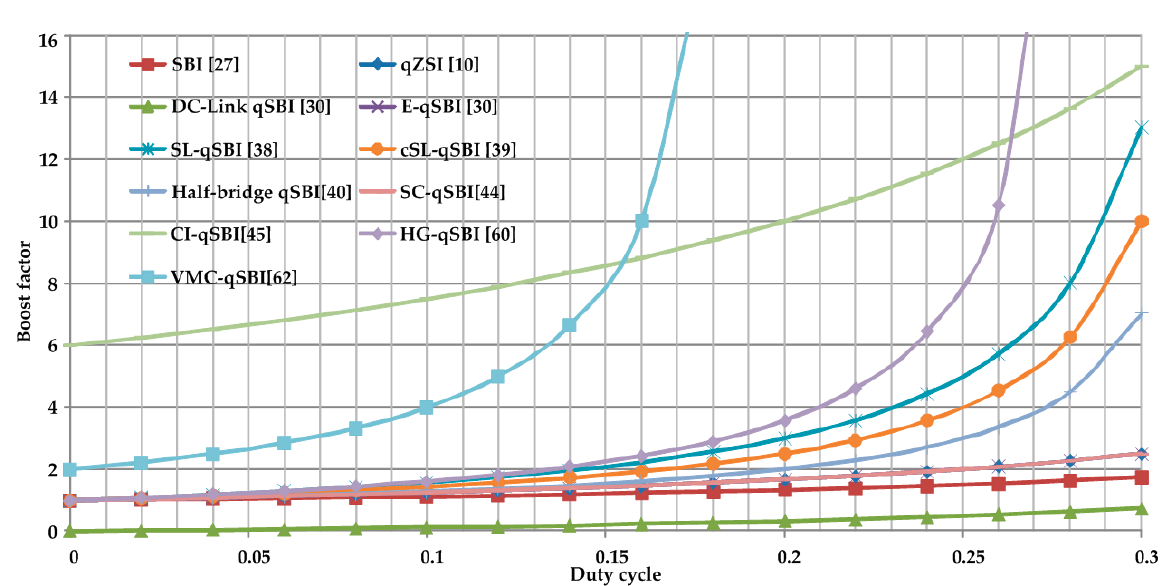
Figure 21. Boost factor as a function of the duty cycle for the topologies enlisted in Table 1.